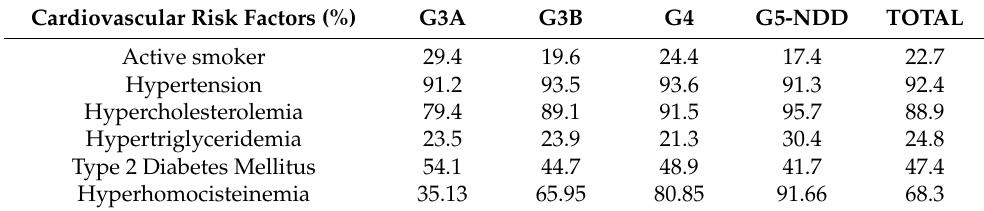
Table 2. Prevalence of global cardiovascular risk factors according to CKD stages.